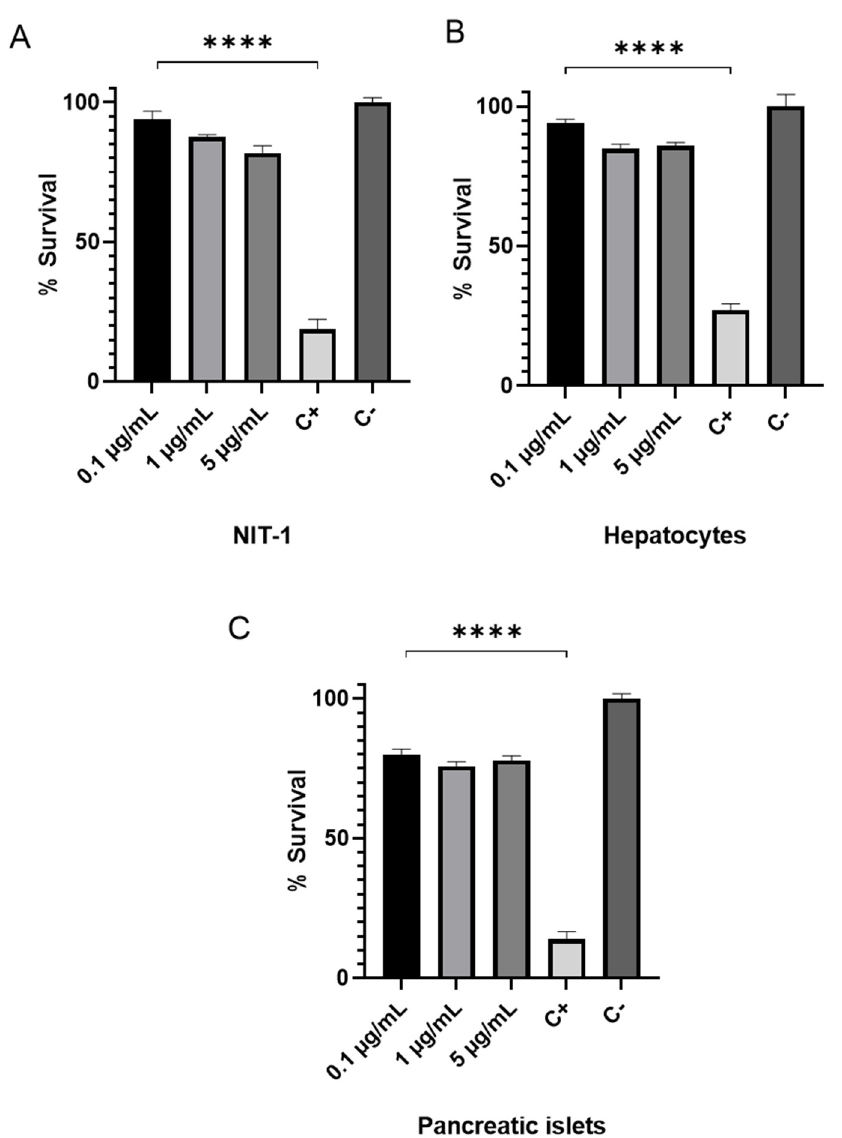
Figure 1. Impact of s-cal14.2b on NIT-1 and primary hepatic and pancreatic cell viability in vitro. The CellTiter 96 ® Aqueous Cell Proliferation Assay was used to measure any changes to cell viability following treatment with 0.1, 1, and 5 µ g/mL s-cal14.2b. ( A ) Cell viability of NIT-1 cells significantly decreased by 18% in response to 5 µ g/mL s-cal14.2b (when compared to the negative control). ( B ) Cell viability of primary hepatocytes decreased by 15% and 14% following treatment with 1 and 5 µ g/mL s-cal14.2b. ( C ) Cell viability of primary pancreatic significantly decreased by 20%, 24%, and 22% in response to 0.1, 1, and 5 µ g/mL s-cal14.2b, C+ (s-cal14.1a) related peptide with cytotoxic activity, C- PBS 1x (s-cal14.2b solvent). Results are expressed mean ± SEM cell viability assays conducted in triplicate ( n = 3). Statistical significance denoted by **** p < 0.0001 between control positive and s-cal14.2b